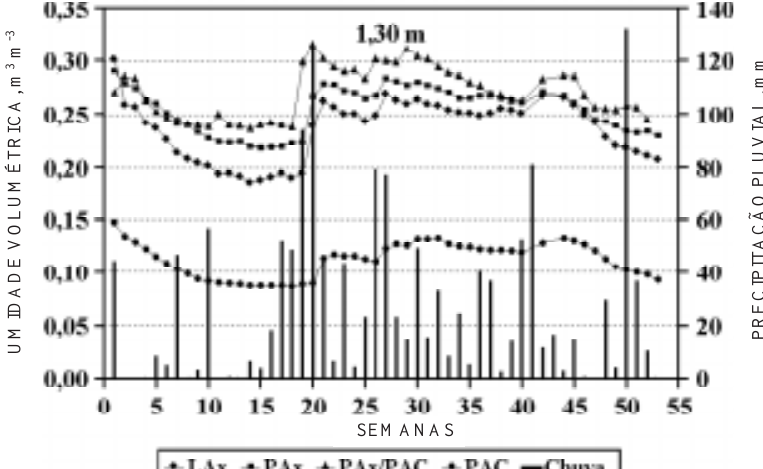
Figura 8. Variação da umidade nos solos Latossolo Amarelo argissólico (LAx), Argissolo Amarelo (PAx), solo transicional PAx/PAC e Argissolo Acinzentado (PAC), nas 53 semanas de avaliação, na profundidade de 1,30 m, e precipitação pluvial no período, em uma toposseqüência em tabuleiro do estado da